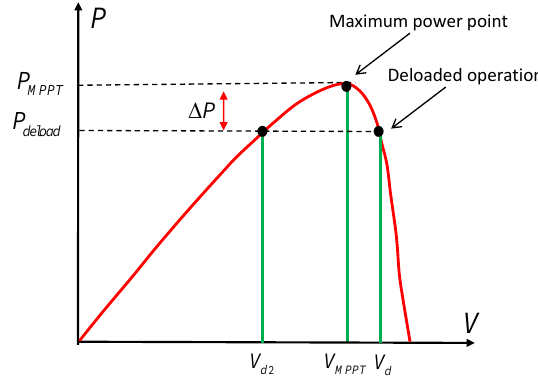
Figure 2. Deloading process in photovoltaic power plants